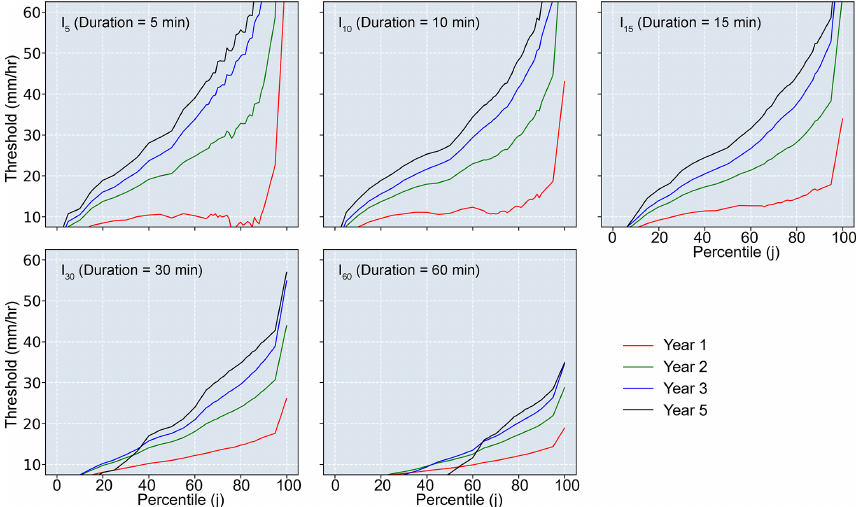
Figure 4. The rainfall intensity–duration threshold for flash floods derived from the best linear relation for different durations and percentiles of the most intense rainfall field in post-fire years 1, 2, 3, and